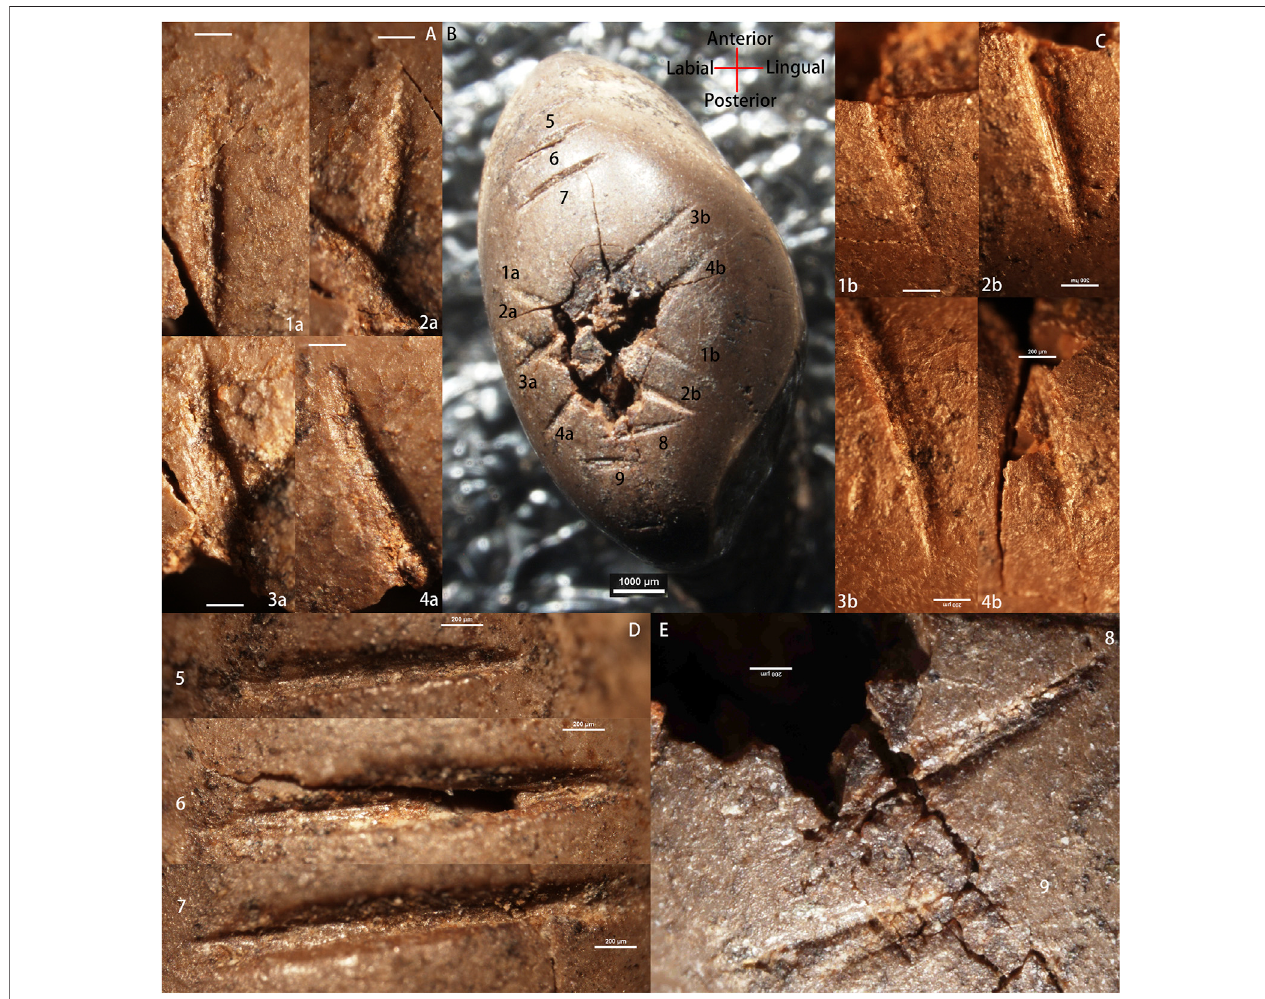
FIGURE7| IncisionsonocclusalsurfaceoftheQG10artifact. (A) Microphotographs ofthestartingpoints(1a – 4a)forincisions L1-L4; (B) Location oftheincisions; (C) Microphotographs of the end points (1b – 4b) for incisions L1-L4; (D) Microphotographs of incisions L5, L6 and L7. (E) Microphotograph of incisions L8 and L9. Scales: (A,C – E) 200 μ m; (B) 1,000 μ